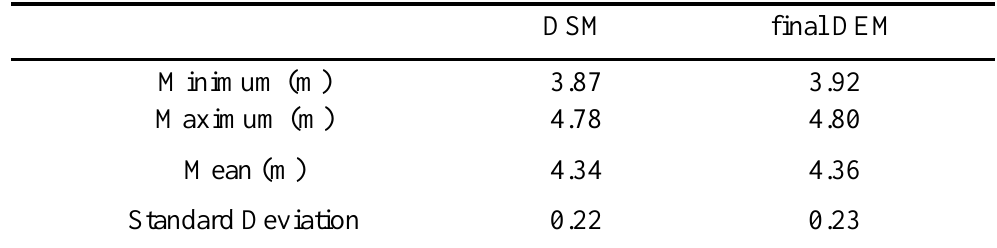
Table 2. Comparison of elevation values between the DSM and final DEM for the validation